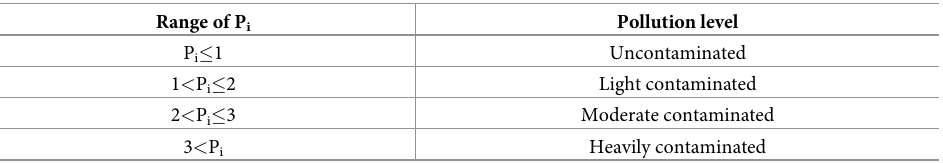
Table 3. Single factor pollution index